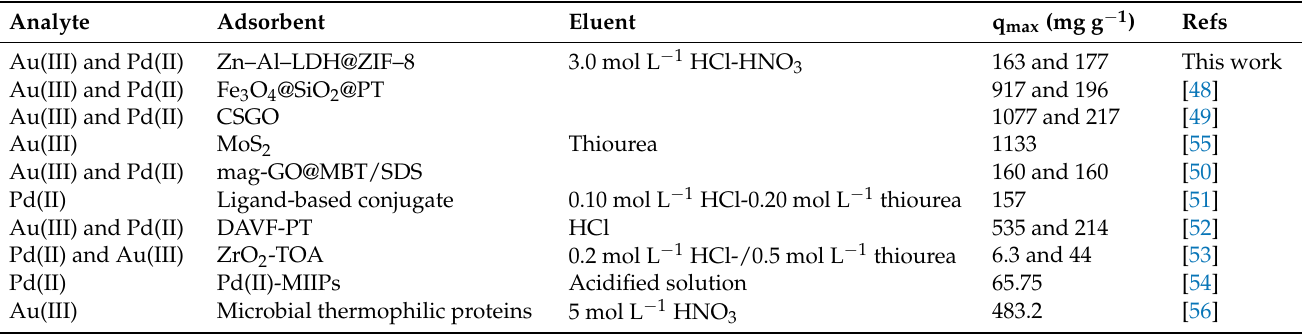
Table 4. Comparison of the adsorption capacities of Zn–Al–LDH@ZIF–8 on different